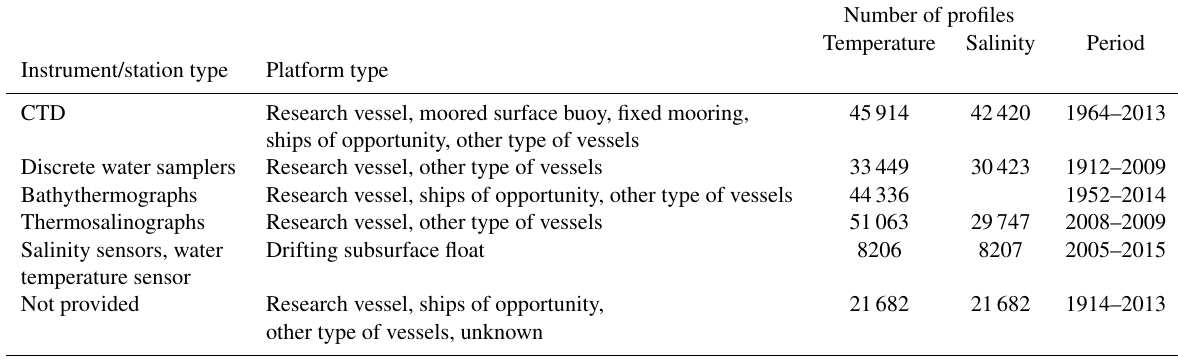
Table 3. Data distribution per instrument, station, and platform type.